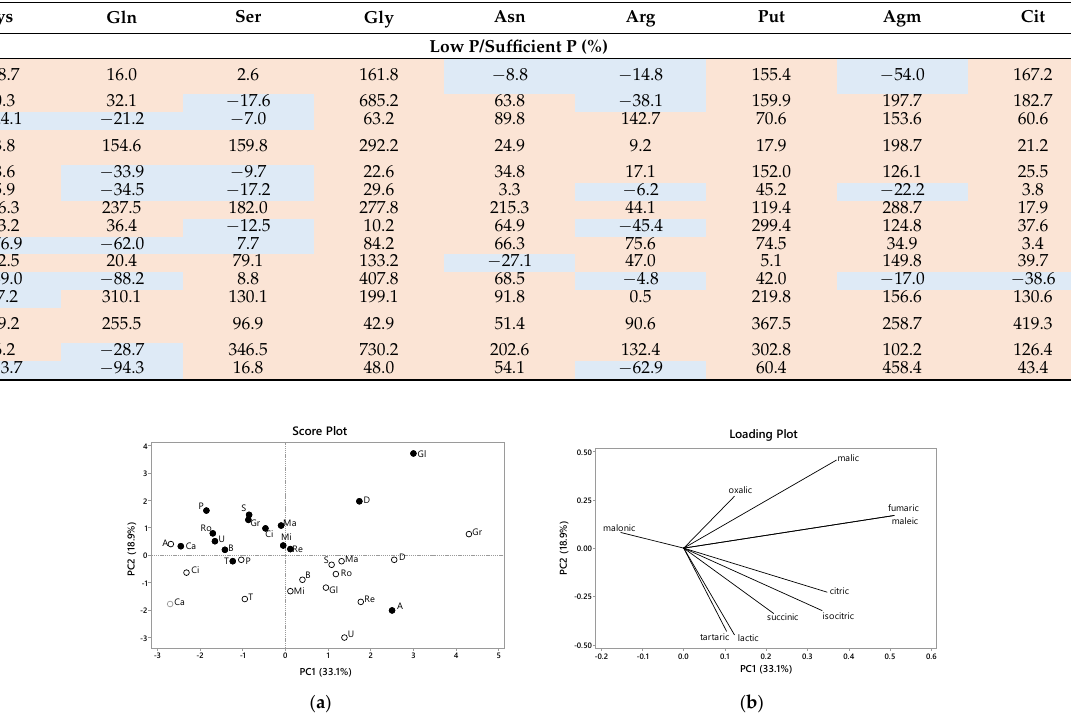
Figure 8. Score ( a ) and loading ( b ) plots for PC1 vs. PC2 for organic acids amounts in the root exudates of seedlings of fifteen eucalypt species grown under low (white) and sufficient (black) P concentrations. Abbreviations: A— E. acmenoides , B— E. brassiana, Ca— E. camaldulensis , Ci— C. citriodora ,